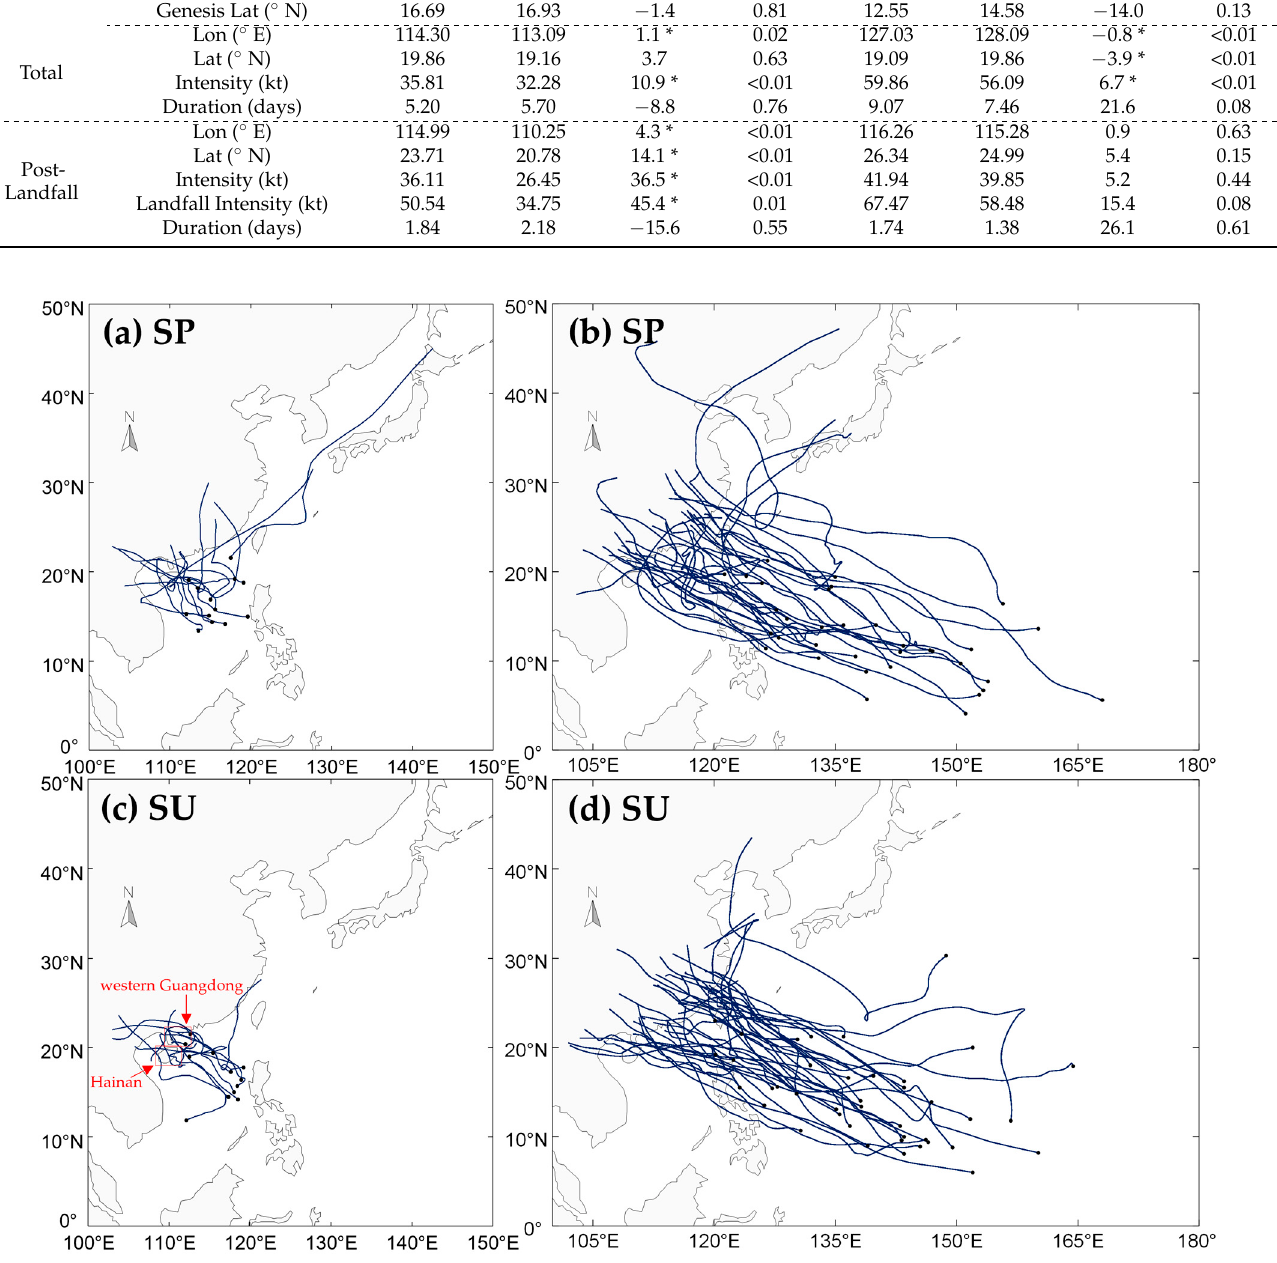
Figure 4. The best track data for landfalling TCs with different genesis locations (i.e., ( a , c ) the SCS and ( b , d ) WNP) in SP and SU El Niño years. The black dots denote the genesis positions. The TC parameters of TCs after landfall were also examined (Table 3). Compared to SU El Niño years, the average position of TC SCS shifted signi fi cantly northeastward in SP El Niño years ( p < 0.01). This could be veri fi ed by their moving tracks. In the WNP region, the average position of TCs in SP El Niño years also shifted northeastward compared to that in SU El Niño years, but this did not pass the statistical signi fi cance test. In terms of intensity, the average post-landfall intensity of TC SCS was signi fi cantly stronger in SP El Niño years ( p < 0.01). It is also worth noting that the landfall intensity of TC SCS in SU El Niño years was apparently weaker than that of SP El Niño years ( p = 0.01) because TC SCS usually made landfall at the TD+TS level in SU El Niño years (Figure 3b). 3.3. TCs Making Landfall in East and South China Likewise, according to the results of previous studies [11,25], the eastern coastal re- gion of China was subdivided into EC and SC using a 25°N boundary line. There were 387 TCs (85%) that made landfall in SC (TC SC ) from 1951 to 2017, while 66 TCs (15%) made landfall in EC (TC EC ). Among them, 6 TCs made landfall in EC during SP El Niño years and 10 made landfall during SU El Niño years, while 41 and 42 TCs made landfall in SC during SP and SU El Niño years, respectively (Table 4). Figure 5 shows the moving tracks of TCs that made landfall in EC and SC during the two types of El Niño years. TC EC were generated in the WNP region during both types of El Niño years (Figure 5a,c). As seen in